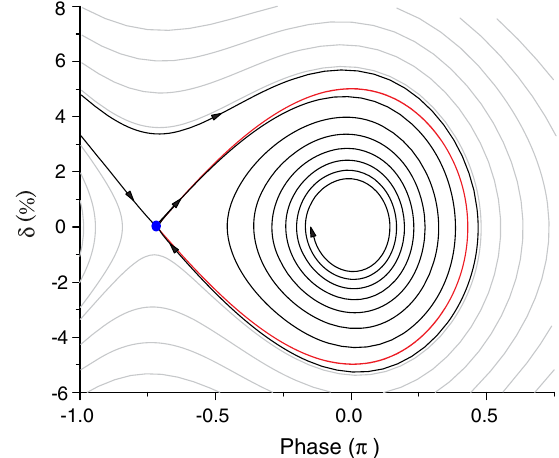
FIG. 1. Longitudinal phase space topologies with synchrotron radiation loss. The origin of the horizontal axis is shifted, corresponding to the synchronous phase. This example is for the synchronous phase of 2.71 rad (155 deg) and the bucket height of 5% according to Eq. (7). The black lines indicate the longitudinal acceptance, and the grey lines the trajectories outside the acceptance. The static bucket is indicated with the red line. The small closed circle (blue) corresponds to an unstable fixed point. are fixed. The trajectory in the longitudinal phase space is still unique when the synchronous phase and bucket height are fixed while the synchrotron tune can then be a free